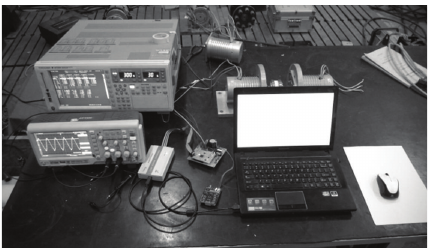
Figure 8: Experimental